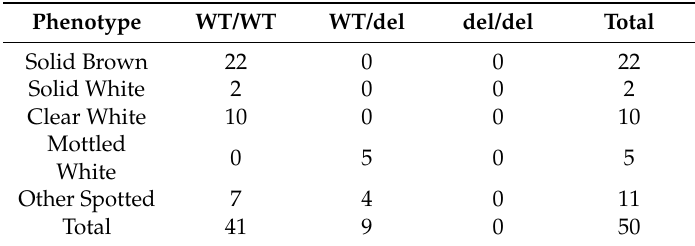
Figure 2. Sanger sequencing confirms the presence of a heterozygous deletion. The KIT :c.1842delG variant results in a frameshift five bases downstream, truncating the protein at the intracellular tyrosine kinase domain. Table 2. Genotyping results for the KIT :c.1842delG mutation ( KIT W1 ).